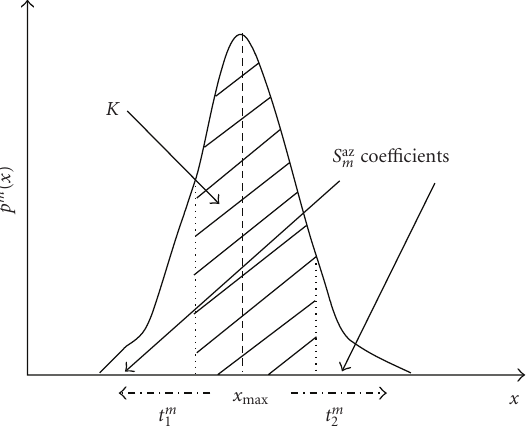
Figure 7: Wavelet coe ffi cient classification